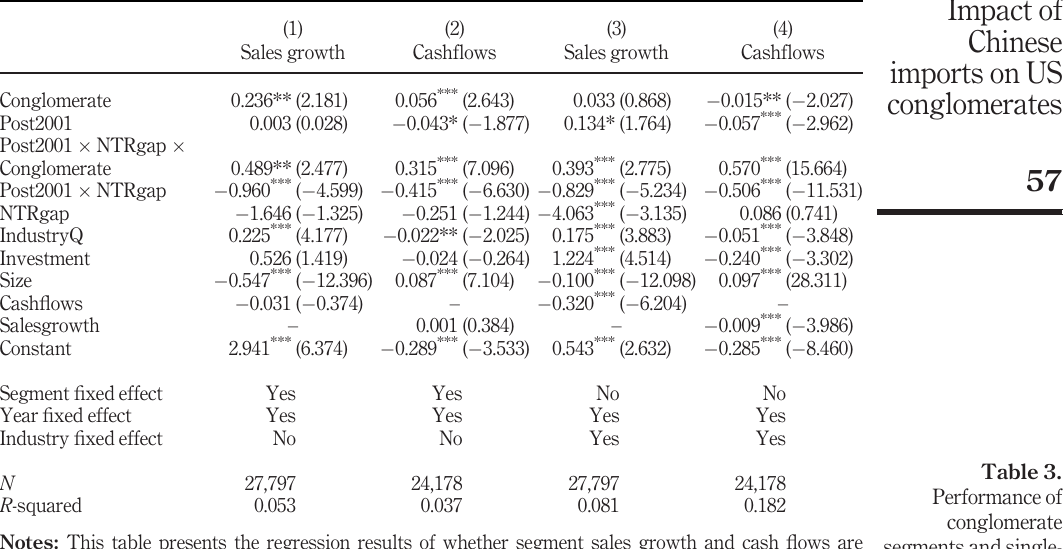
Table 3. Performance of conglomerate segments and single- segment fi rms in the periods before